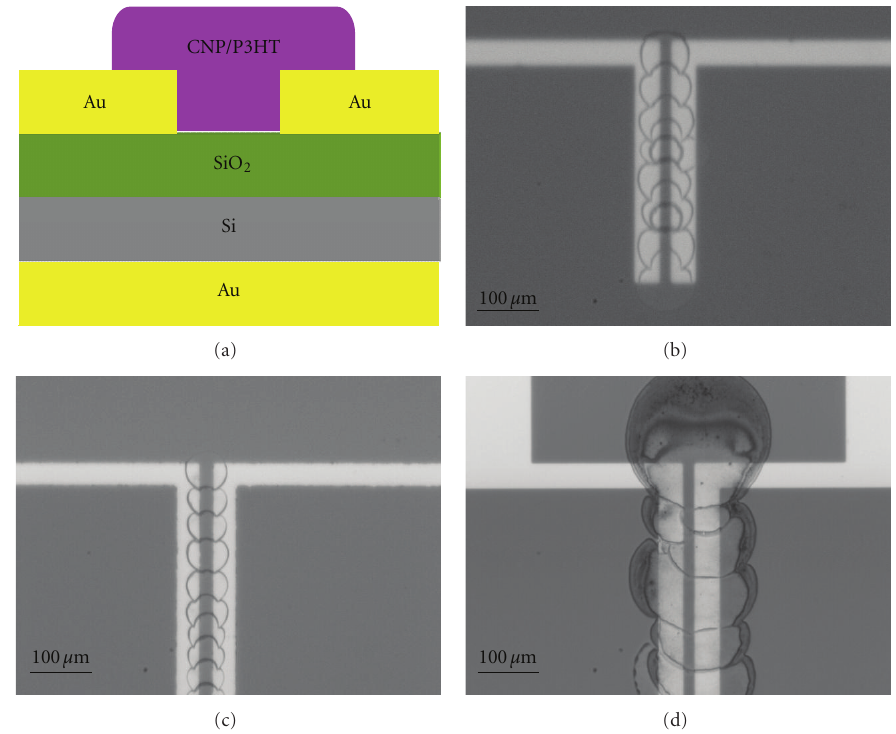
Figure 1: (a) Schematic representation of cross section of the inkjet-printed OFETs, (b), (c), and (d) microscope images of the OFETs for pristine P3HT, CNP/P3HT = 0.1wt.%, and CNP/P3HT = 10wt.%,